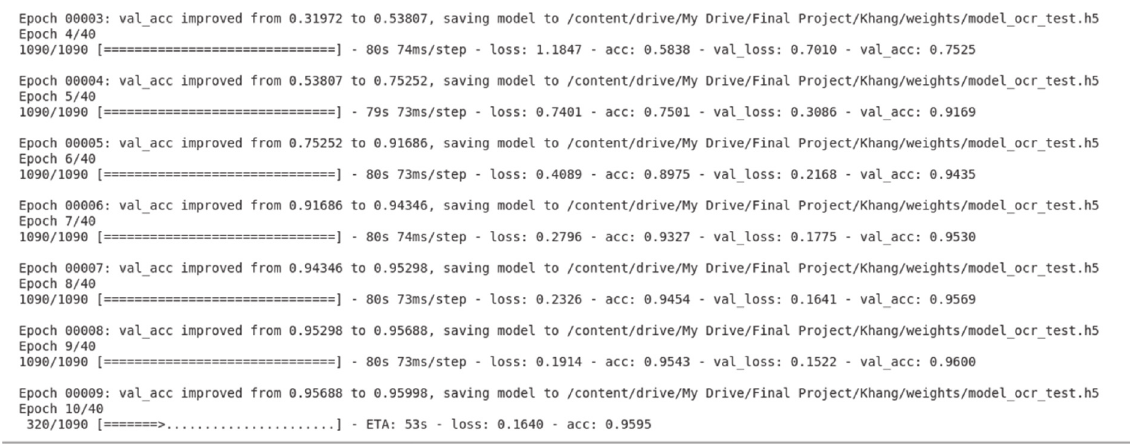
Figure 16: Data training process using the VGG-16